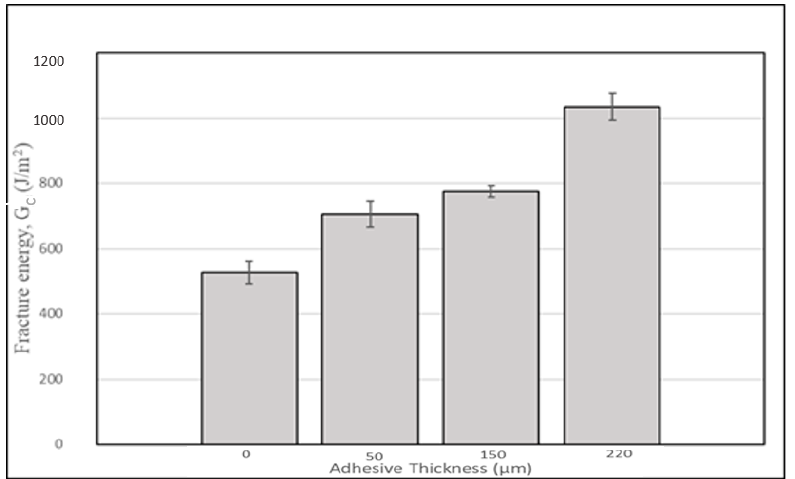
Figure 21. Variation of fracture energy with the interleaving film thickness in Mixed-Mode I/II. Table 5. Effect of interleaving film thickness on the fracture energy in Mixed-Mode I/II.